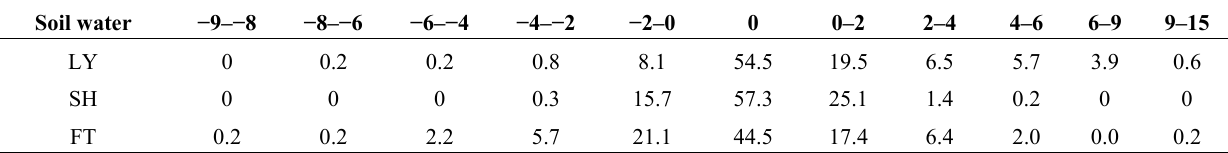
Table 14. Statistic distribution of soil water variation in Scenario S1-S0 (area percentage, %). Soil water